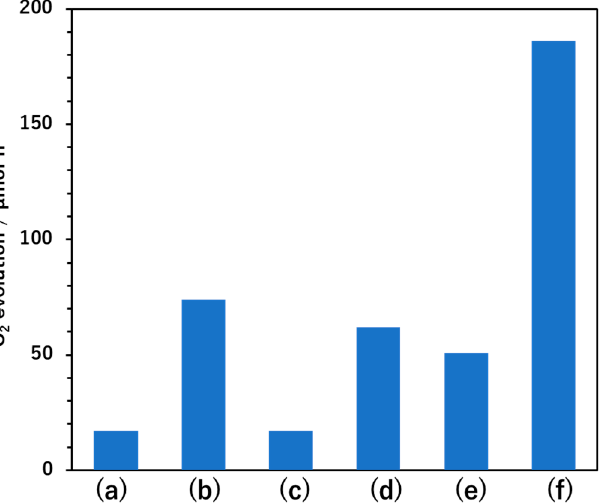
Figure 5. Oxygen evolution rates obtained for BaTaO 2 N:Mg loaded with ( a ) no cocatalyst, ( b ) FeO x by impregnation–nitrogen annealing, ( c ) FeO x by impregnation–ammonia nitridation, ( d ) FeO